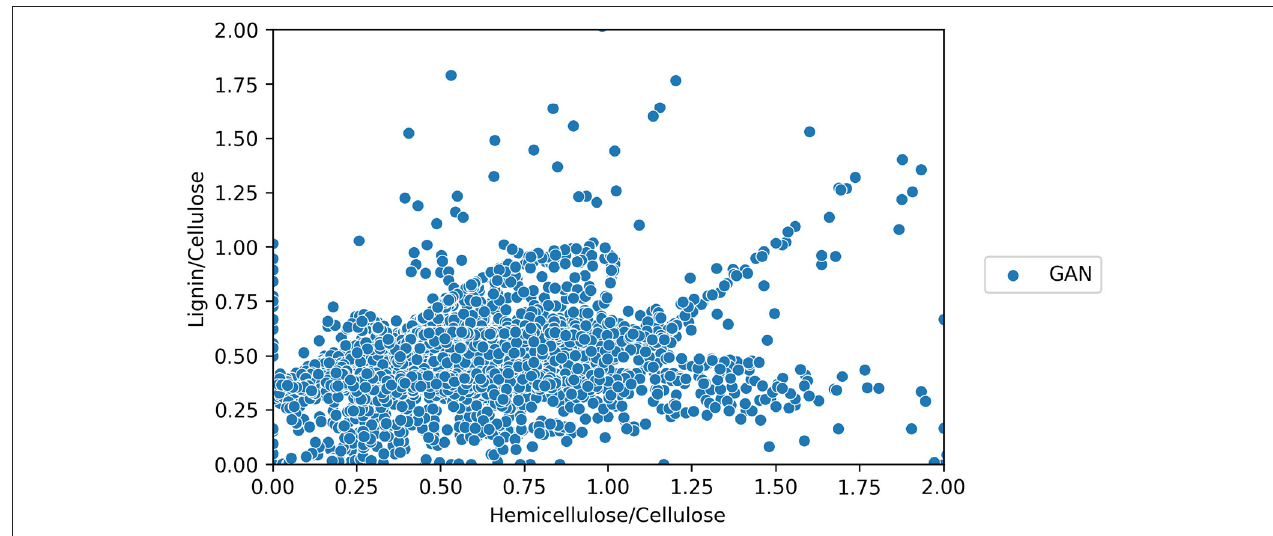
FIGURE 3 | Feedstock lignin/cellulose to hemicellulose/cellulose ratios of the Generative Adversarial Network (GAN) sample data.